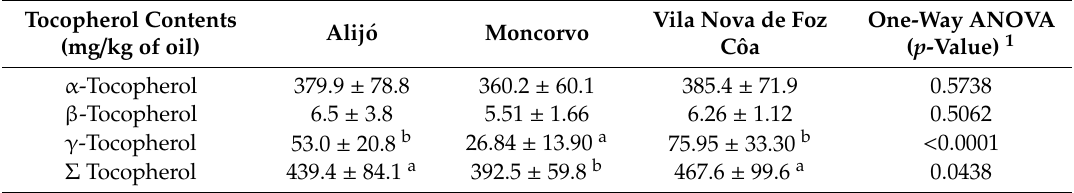
Table 3. Tocopherol contents (mg / kg of oil) of α -. β - and γ -tocopherols as well as Vitamin E (total tocopherol content) found in oils extracted from oleaster (mean ± standard deviation) collected